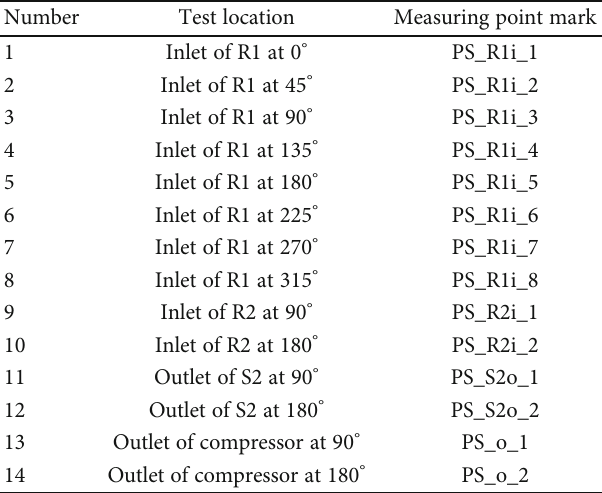
Table 2: Dynamic test parameters of the two-stage high-speed